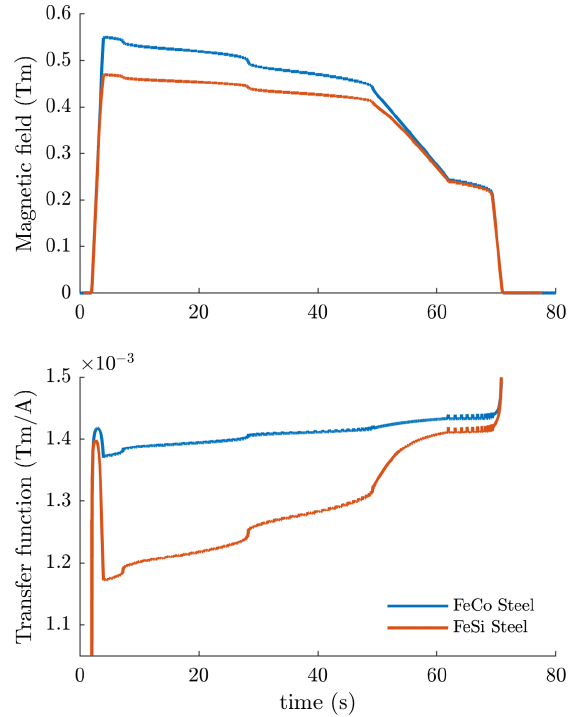
FIG. 19. Top: integrated magnetic field. Bottom: integrated transfer